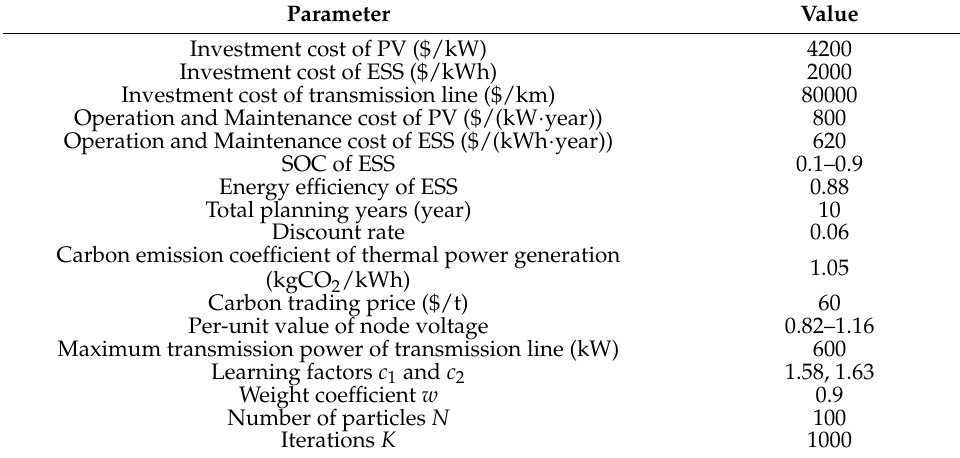
Table 2. Time-of-use price of electricity from the